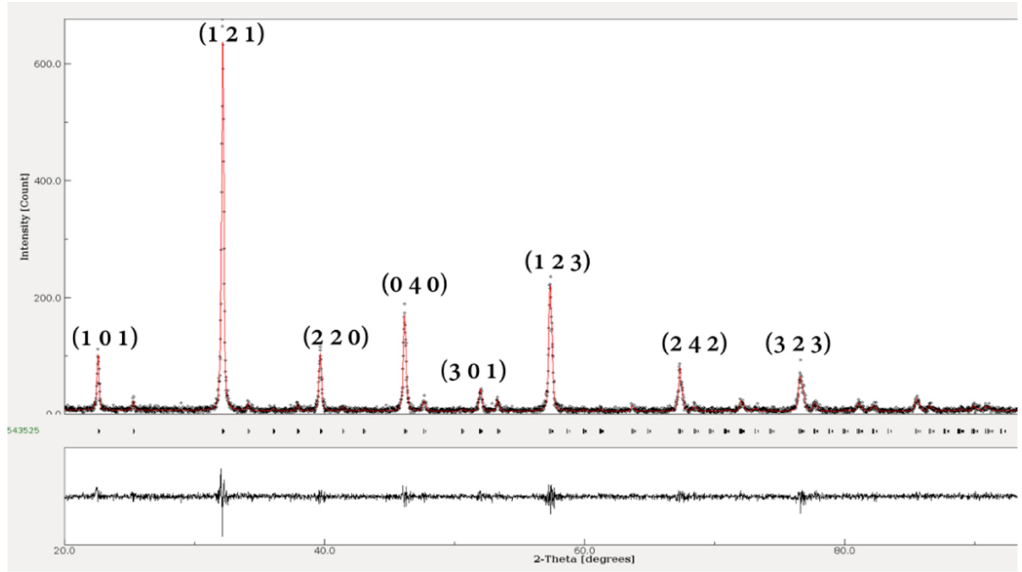
Figure 4. XRD and refinement pattern of LaCrO 3 .